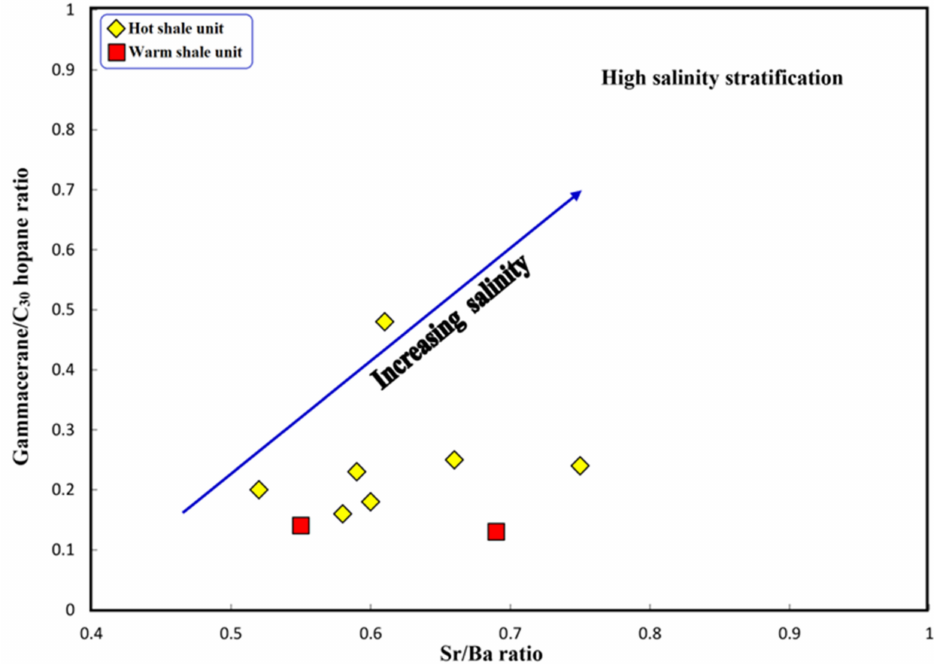
Figure 17. Geochemical correlation between gammacerane/C30 hopane (G/HC 30 ) biomarker and Sr/Ba ratios result of the analyzed shales of the Qusaiba units shows low salinity during deposition of the Qusaiba shale